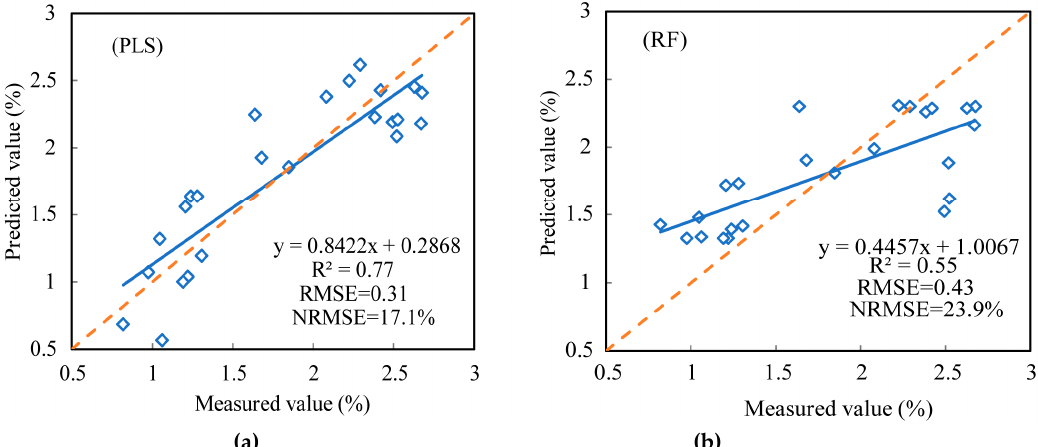
Figure 7. Accuracy of the measured and predicted values of the validation set: ( a ) Partial least squares (PLS) model, ( b ) random forest (RF) model.